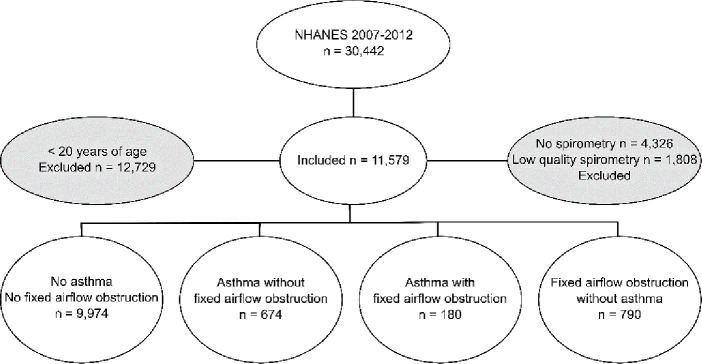
Flow-chart of included individuals.